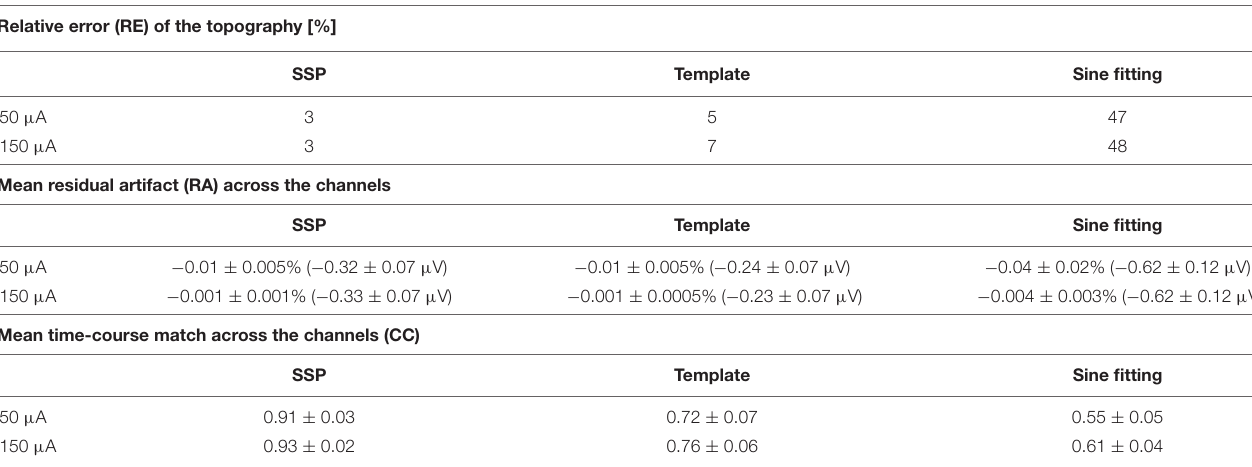
TABLE 2 | Comparison of the artifact-correction performance. Relative error (RE) of the topography [%]